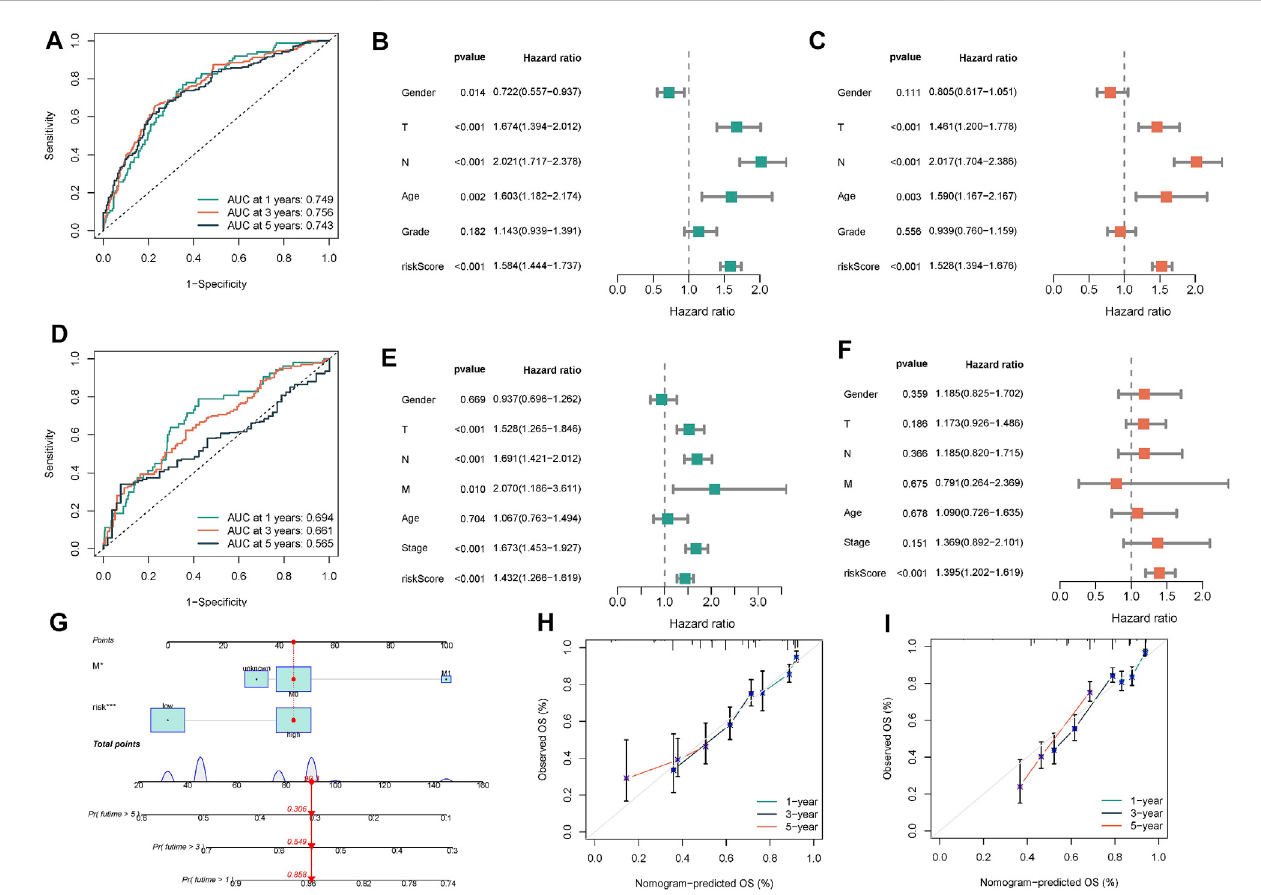
FIGURE 6 Constructionand validation of nomogram. (A) The ROC curve wasperformed to verify thepredictiveperformance of predictivemodel. (B,C) Univariate/ multivariate Cox regression model was constructed to verify the independent predictive performance of each parameter in TCGA-BLCA cohort. (D – F) ROC curve and Univariate/multivariate Cox regression model wereplotted to verify inGEO database. (G) Construction of anomogram combining M stage and risk score. (H,I) Calibration plot showing that nomogram-predicted survival probabilities corresponded closely to the observed